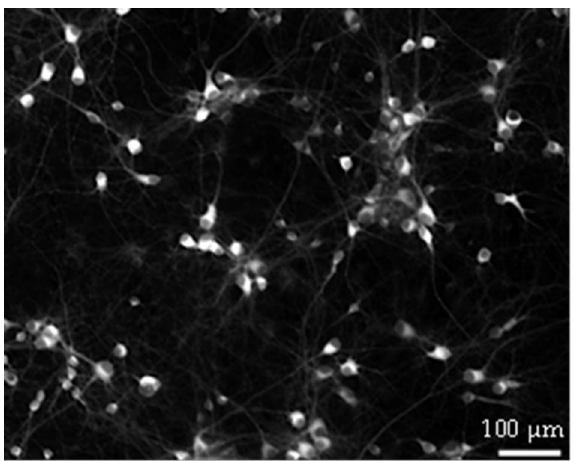
Figure 7. Example of hippocampal neurons plated on Micro-Electrode Array (MEA) at DIV 18. Neurons established a dense connectivity which made it hard to solve their morphology.